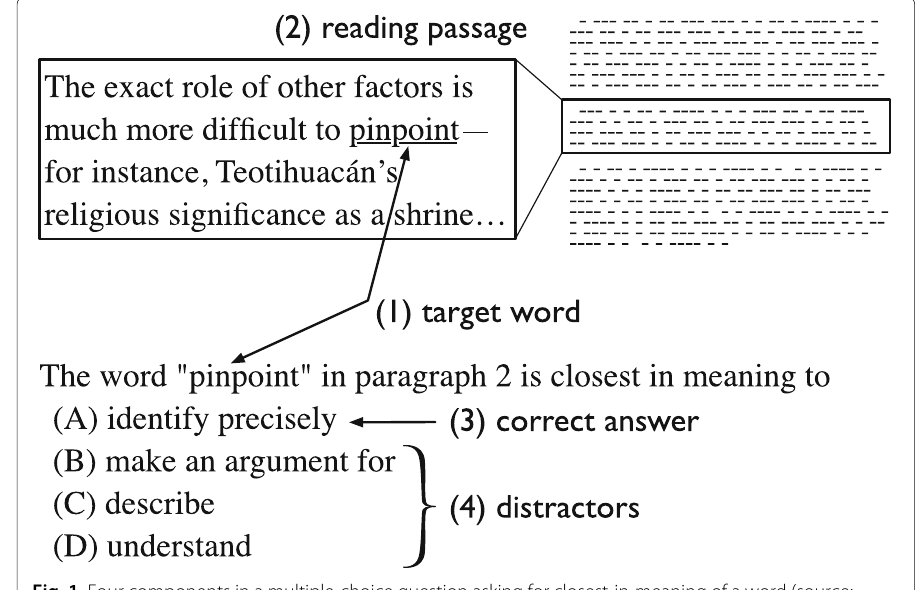
Fig. 1 Four components in a multiple-choice question asking for closest-in-meaning of a word (source: TOEFL iBT question from past test, taken from the official website,